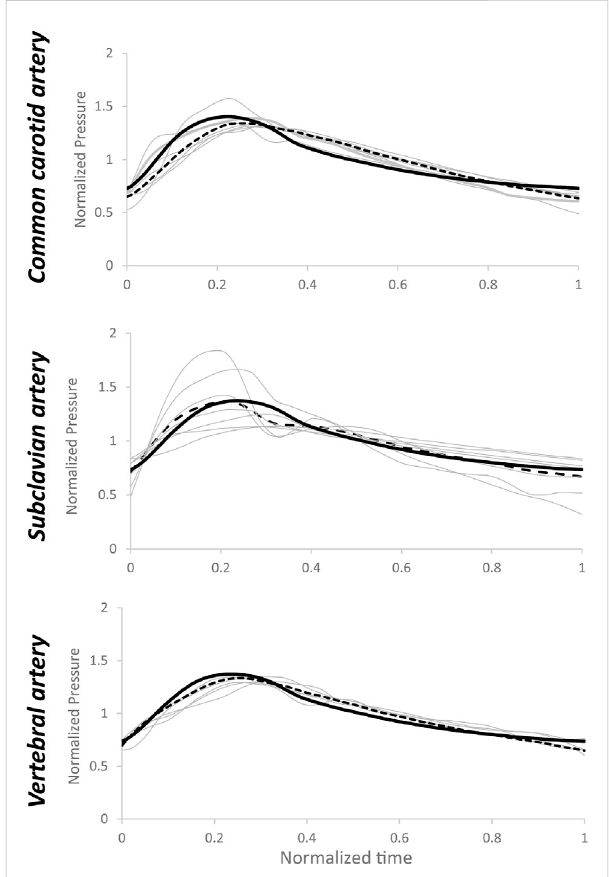
FIGURE 7 Estimated pressure waveforms (grey lines) using patient-speci fi c inputs of fl ow rate data and estimated R 1 , C, and R 2 values based on medians of arterial-speci fi c parameters. Dotted lines represent the averageofestimatedpressure,whiletheblacklinerepresentsthe average value of measured pressure. Normalization has been performed post-simulation for comparison